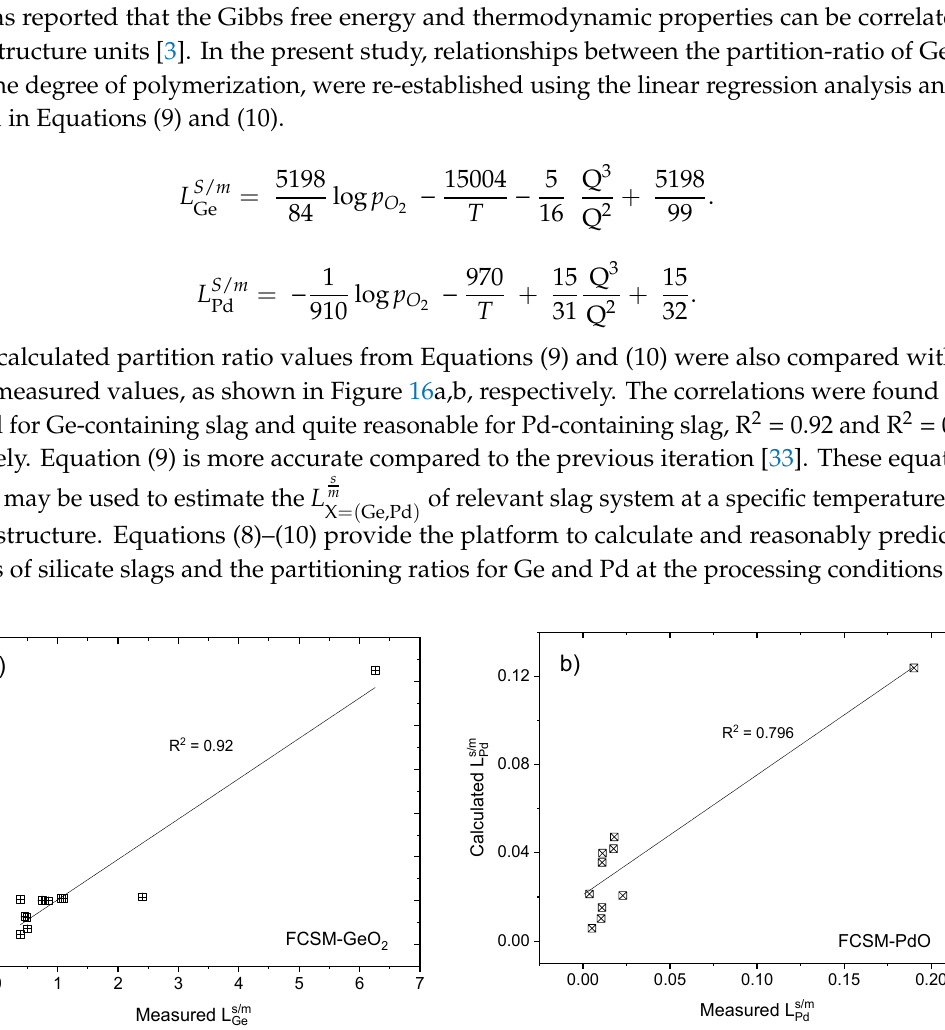
Figure 16. Comparison of calculated and measured values of the partitioning ratios of ( a ) Ge and ( b ) Pd in the FCSM slag.